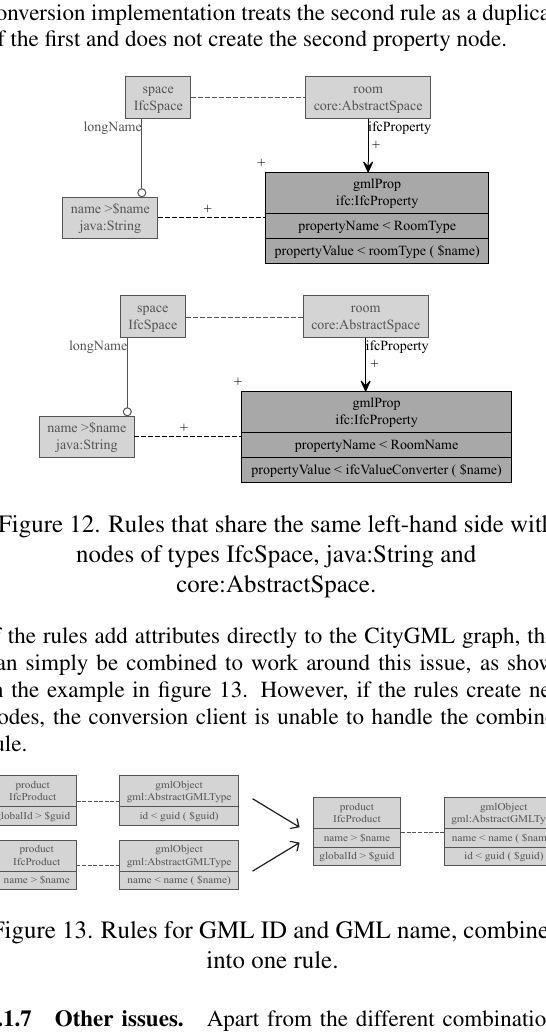
Figure 14. Rule that creates a node of type Solid which has no corresponding node in the IFC